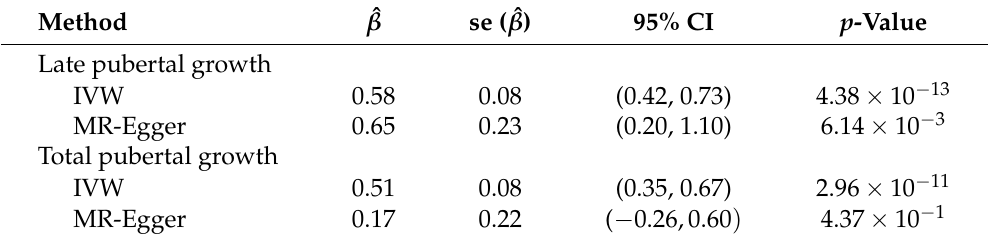
Table 4. Summary of estimate of β if no other exposure GWASs are